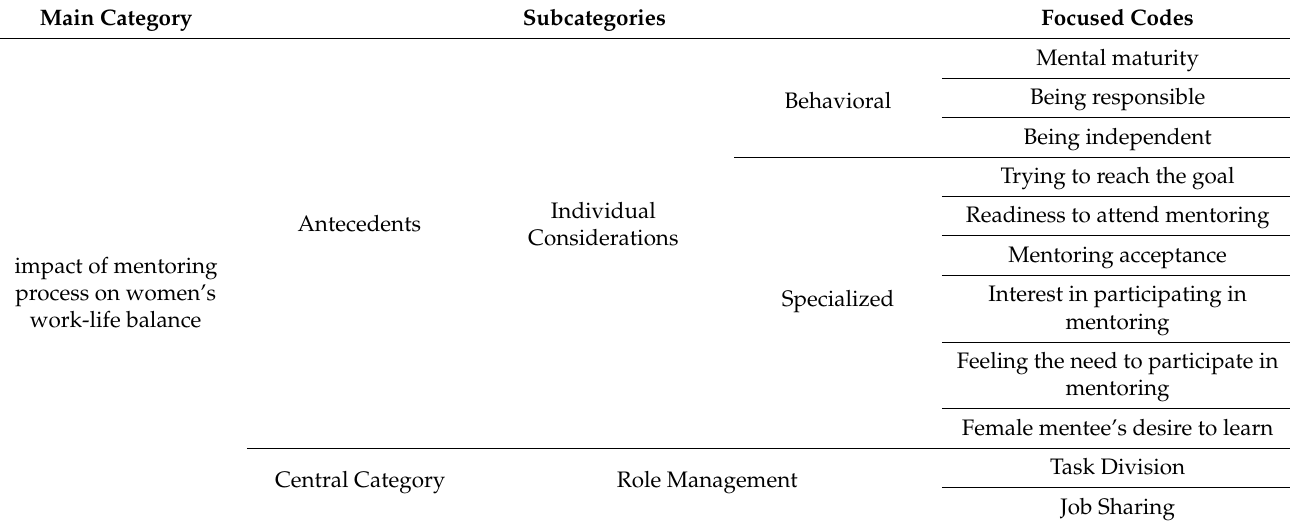
Table 4. Examples of Axial